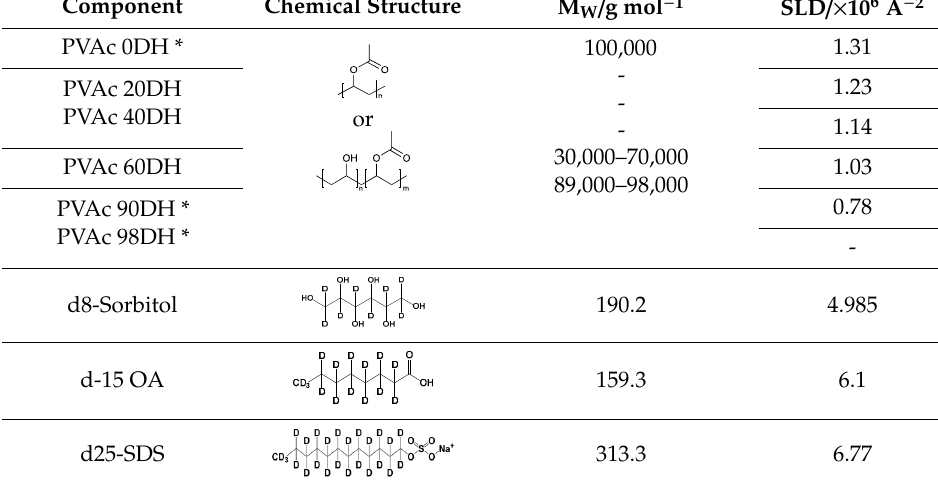
Table 1. Physicochemical characteristics of the components such as molecular weight (Mw), scattering length density (SLD), and chemical structure. Molecules with an asterisk designate commercial components. SLDs of the synthesised polymer were calculated via a statistical average of the SLDs for pure poly(vinyl acetate) (PVAc) and polyvinyl alcohol performed with the analysis software IGOR Pro, using the Motofit package [26] (Tables S10, S12 and